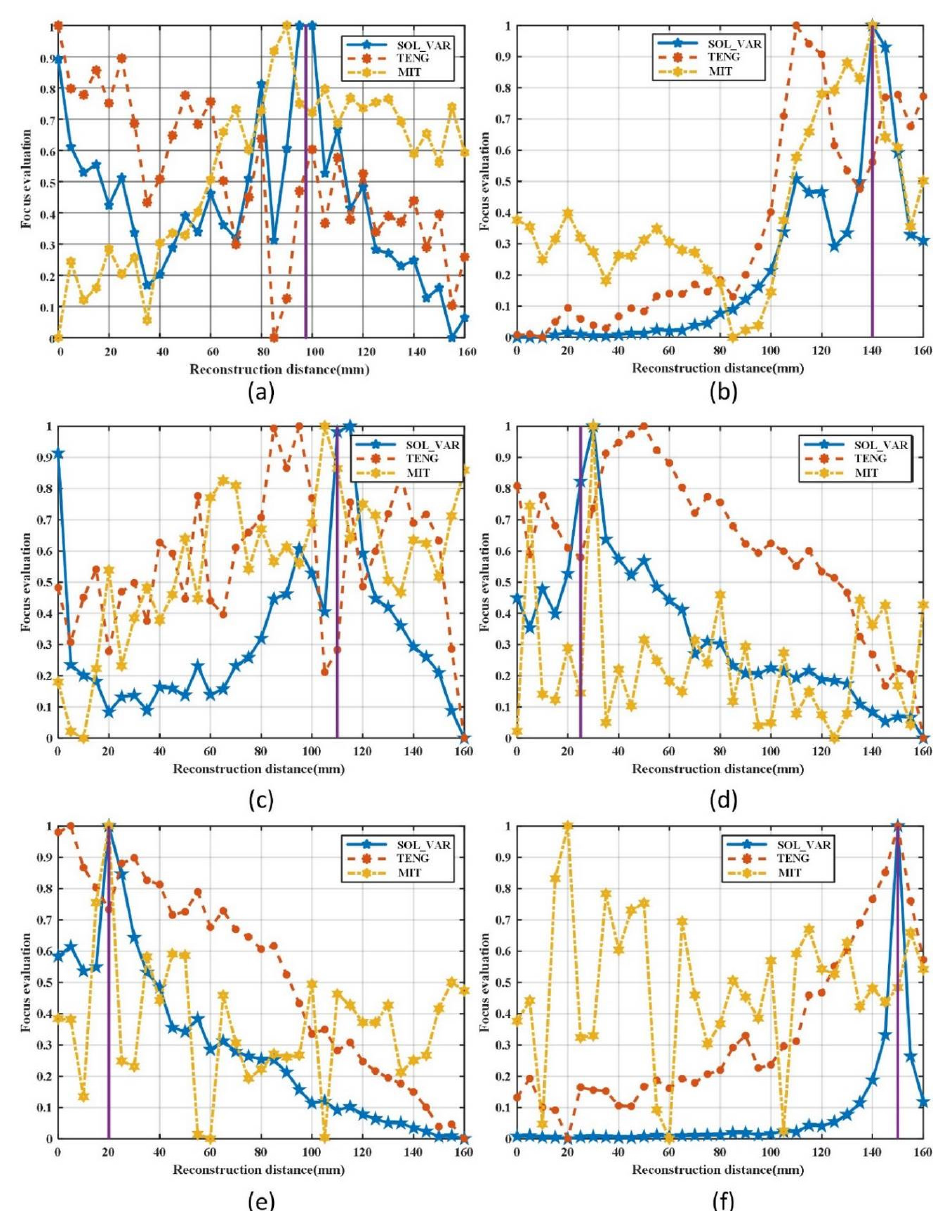
Figure 14. The focus evaluation with the functions of SOL_VAR, TENG, and MIT after reconstructing the hologram with a step size of 5 mm. The results are normalized, and ( a – f ) correspond to regions 1–6 of Figure 13. The purple vertical line represents the position of the actual focus plane.